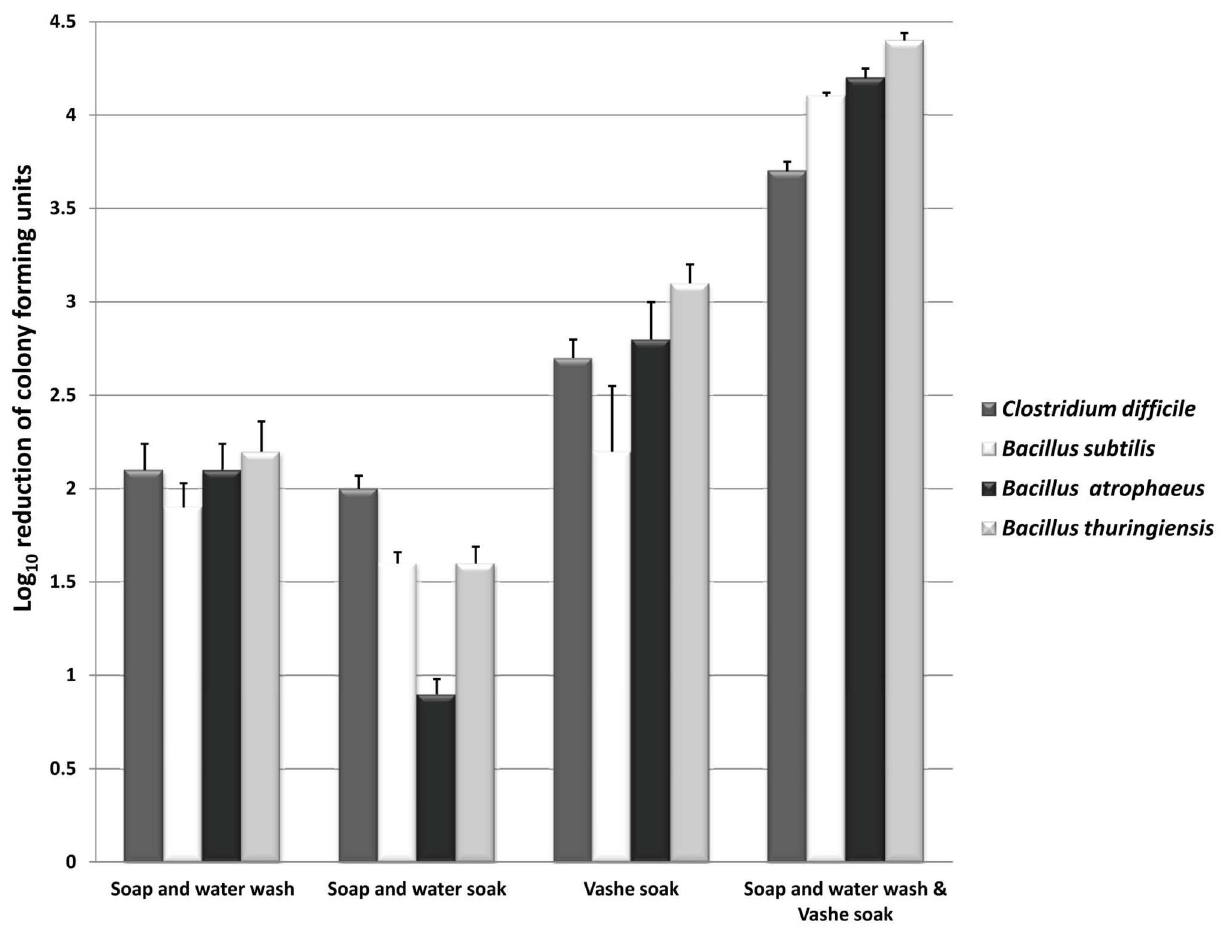
Figure 3. The efficacy of Vashe hand hygiene interventions for removal of B. anthracis surrogates and C. difficile spores from hands. Mean log reduction in recovery of three Bacillus anthracis surrogate strains and one nontoxigenic Clostridium 10 difficile strain from hands after performing hand hygiene interventions. Hand hygiene interventions included soap and water hand wash, soap and water soak, Vashe solution soak, and a coupled approach consisting of a soap and water hand wash followed by Vashe solution soak. For soaking experiments, contaminated hands were immersed in 1 gallon of Vashe solution or 1 gallon of water containing 10 mL of 0.5% triclosan liquid soap and massaged vigorously for 1 minute. Error bars represent standard error.